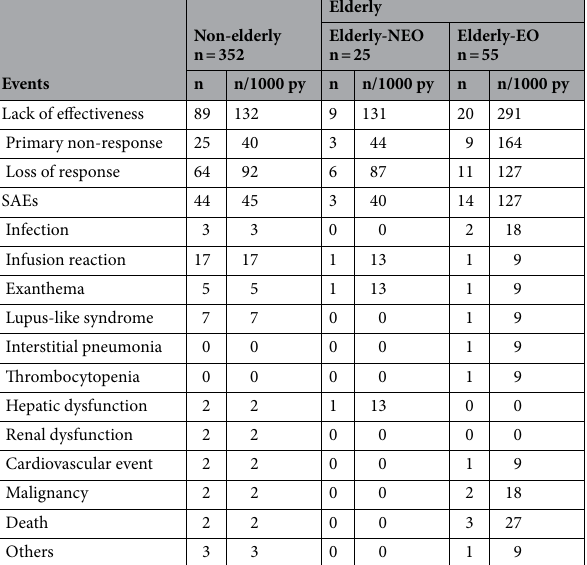
Table 4. The events leading the discontinuation of anti-TNF treatment. Anti-TNF anti-tumor necrosis factor, EO elderly onset, IBD inflammatory bowel disease, NEO non-elderly onset, py patient-years, SAEs severe adverse